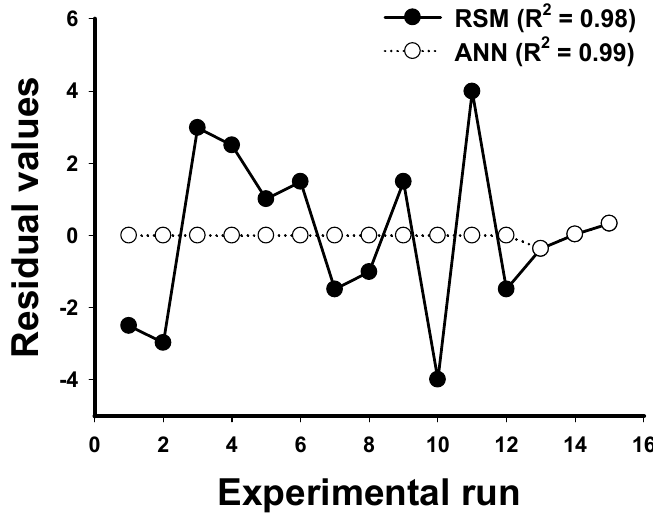
Figure 5. The distribution of residual values for each experimental run of Box-Behnken design experiments employing the RSM and ANN models. Coefficient of determination ( R 2 ) calculated from the design data for RSM and ANN models were 0.98 and 0.99, respectively. Residual values: predicted values minus actual values.